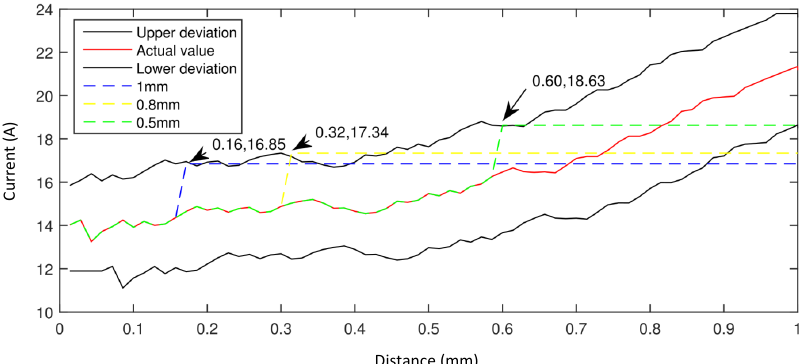
Figure 9. Result of self-adaptive mold protection method. The blue profiles are the 50 curves filtered by EKF . The red profile is upper deviation curve, and the purple one is the lower deviation curve.